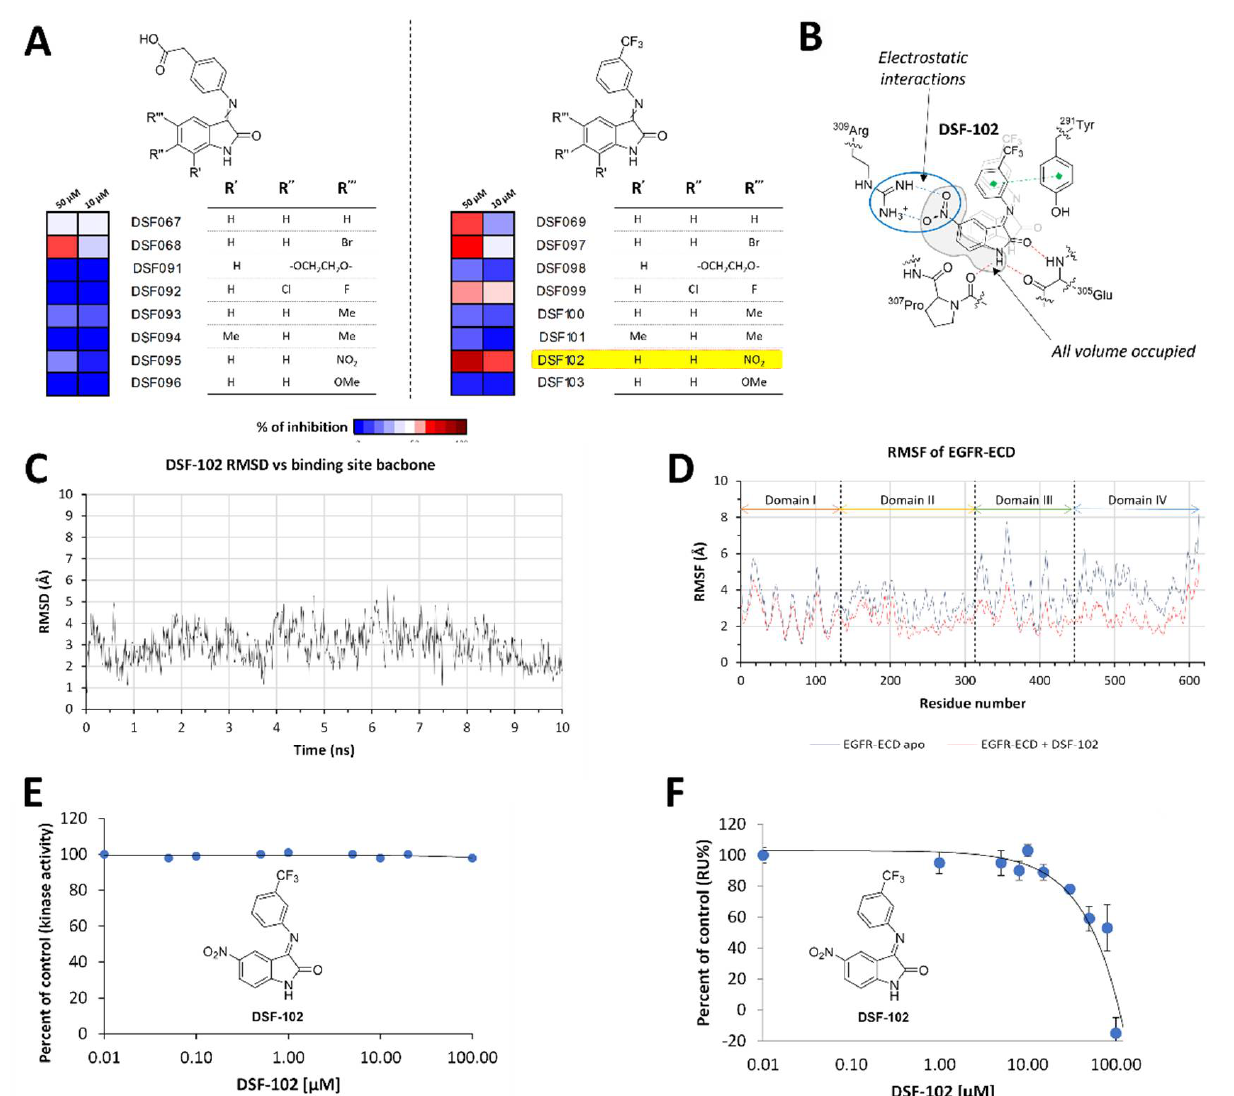
Figure 3. ( A ) Heat-map representing the percentage of EGFR dimerization inhibition at 50 and 10 μM. ( B ) Binding mode proposed for DSF-102 and EGFR-ECD. Hydrogen bonds are depicted as red dashed lines; π-π interaction are depicted as green dashed lines; electrostatic interactions are de- picted as blue dashed lines. The binding mode of DSF-069 (light gray) is also reported to show how DSF-102 resulted slightly shifted with respect to the parent compound, thus leading to a higher complementarity with the binding pocket. ( C ) Root mean squared deviation (RMSD, Å) for DSF- 102 during 10 ns of MD simulation. ( D ) Comparison of per-residue root mean squared fluctuation (RMSF, Å) obtained during 10 ns of MD simulation of apo EGFR-ECD (blue line) and DSF-102 bound EGFR-ECD (red line). ( E ) Residual catalytic activity (%) of the isolated kinase domain of EGFR upon treatment with DSF-102 . Please note that no inhibition was observed up to 100 μM. ( F ) DSF-102 dependent inhibition of the binding between EGF and isolated EGFR-ECD as measured by SPR analysis. Since the biological evaluation of the newly synthesized compounds agreed with the predicted binding site for isatin Schiff bases (i.e., a region between domains II and III of EGFR-ECD; Figure 2B), additional molecular docking simulations were conducted with DSF-102 . These studies further confirmed that the nitro function established electrostatic interactions with the polar head of 309 Arg (Figure 3B). We also noted that the docking pose of DSF-102 did not perfectly overlap with that predicted for DSF-069 . Indeed, the strong interaction between the nitro and the arginine caused a slight relocation of the compound that resulted able to occupy almost all the binding site (Figure 3B). The amide-NH of DSF- 102 was found to be almost equidistant from the amide C=O of both 305 Glu and 307 Pro, whereas the interactions between the indolinone C=O with the amide-NH of 305 Glu as well as the π-π stacking between the phenylamino moiety and the 291 Tyr sidechain (already observed for DSF-069 ) were retained. Taken together, these data explained the highest